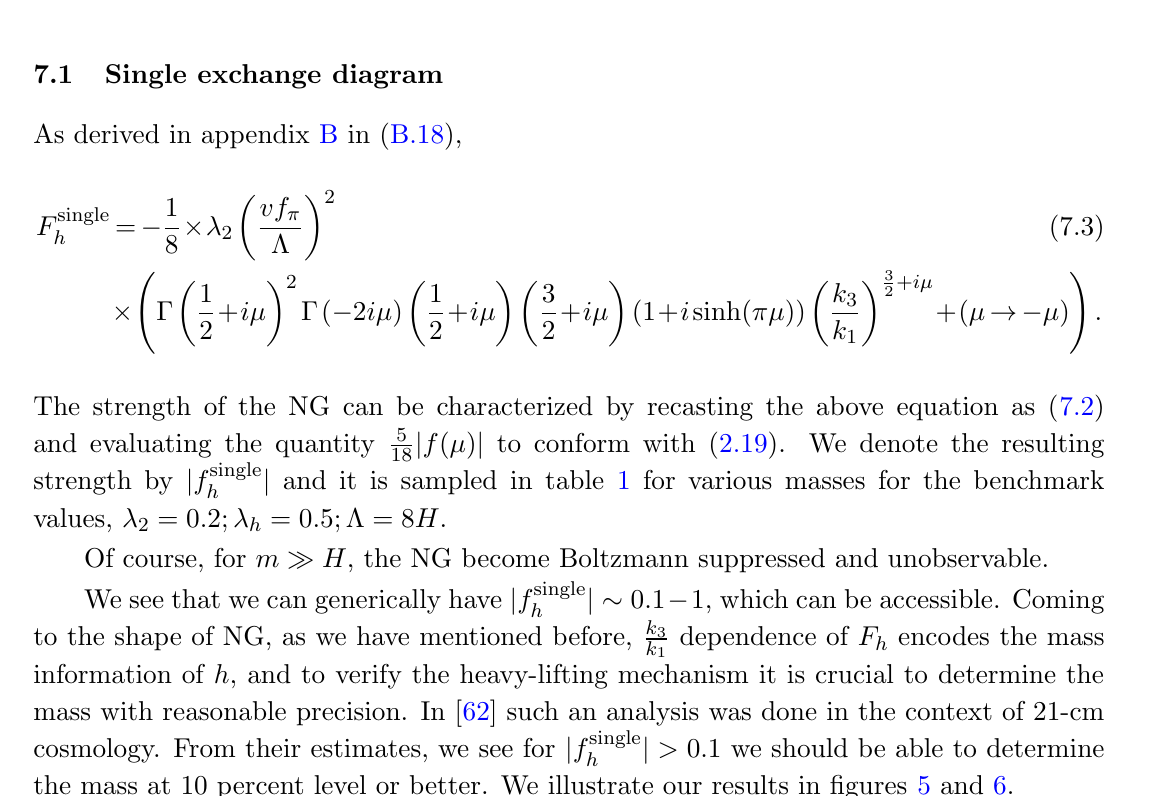
Figure 5 . Dimensionless three-point function F single E(cid:11)ective description (B.18) with (cid:21) 2 = 0 : 2; (cid:21) h = 0 : 5; (cid:3) = 8 H